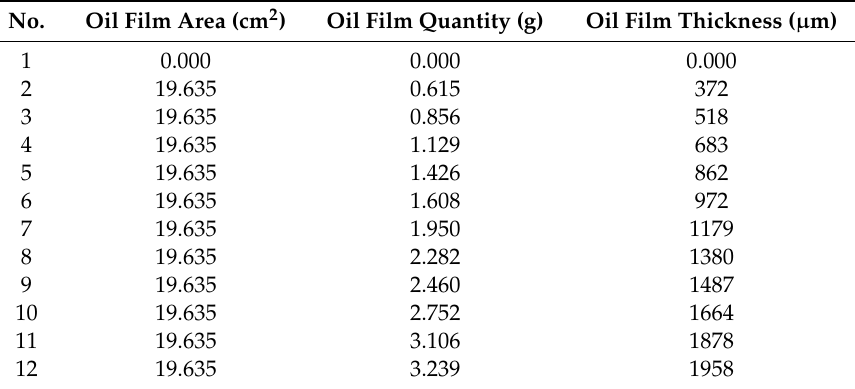
Table 2. Oil film thicknesses in the experimental groups.